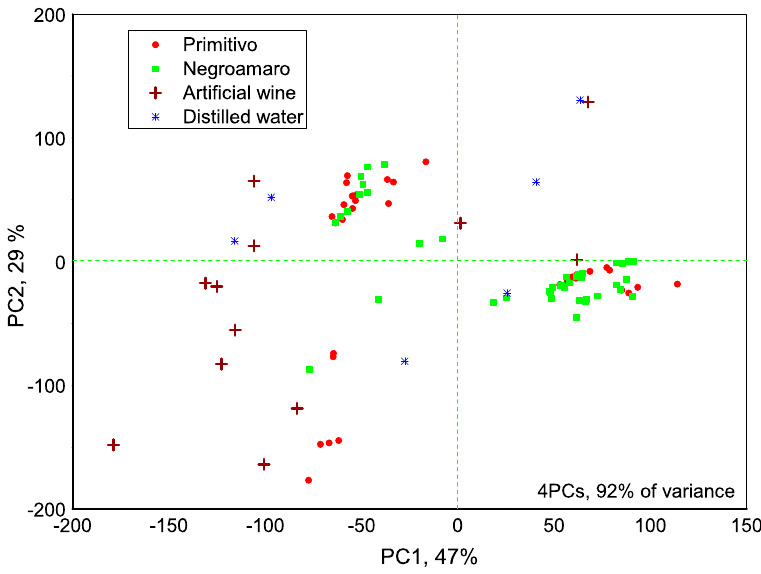
Figure 4. PCA score plot of e-Tongue data dispersion.